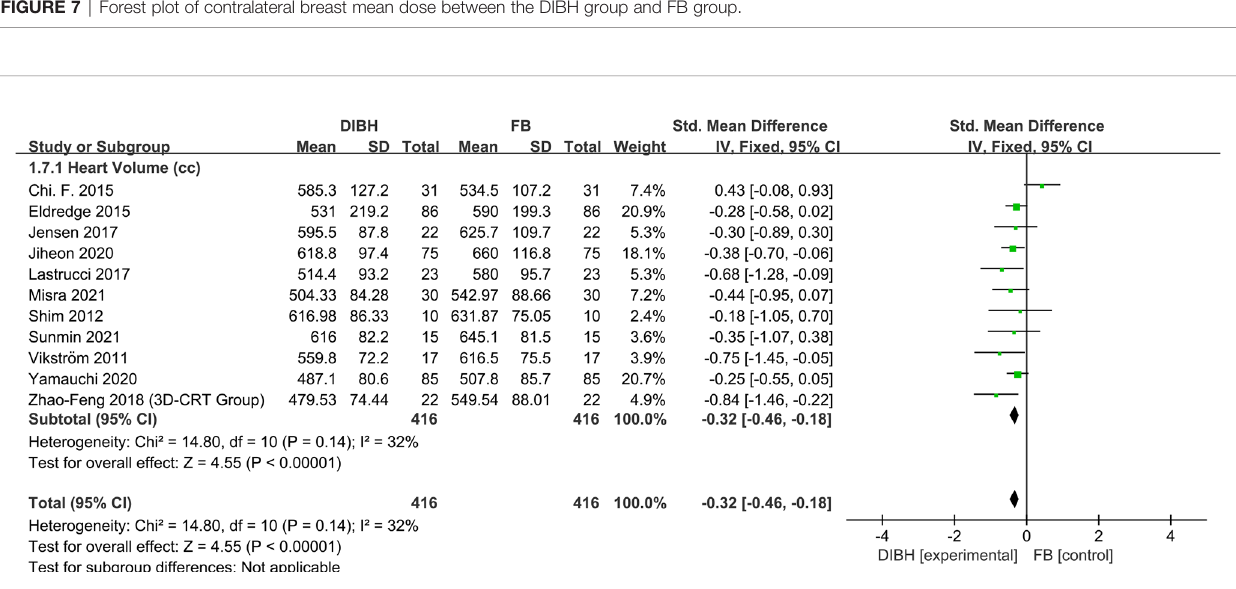
FIGURE 7 | Forest plot of contralateral breast mean dose between the DIBH group and FB